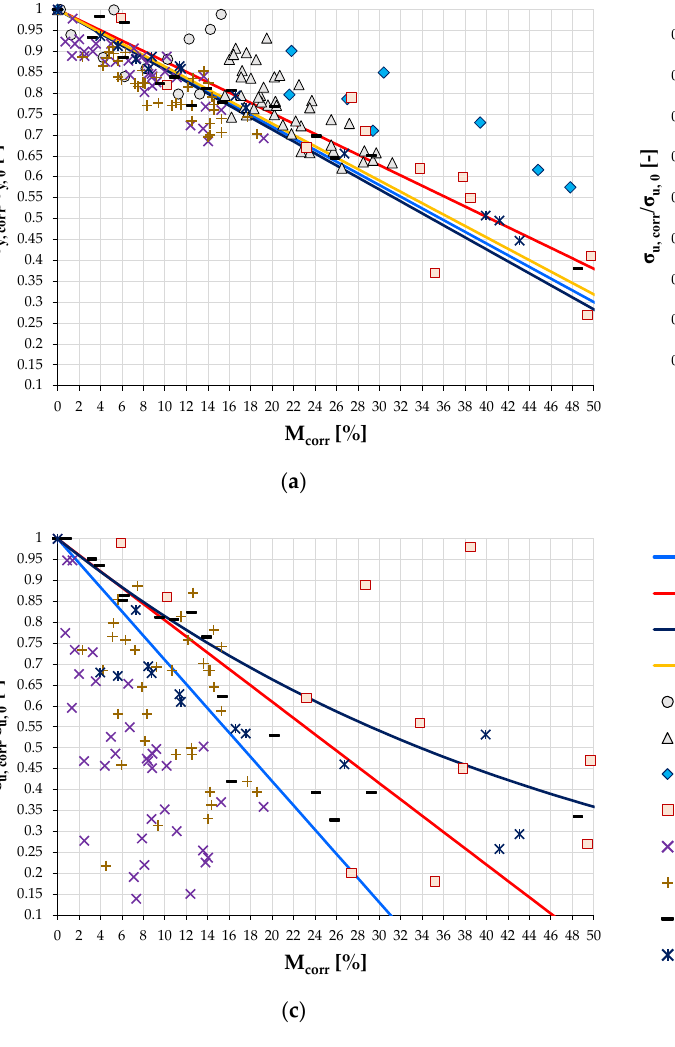
Figure 3. Comparison between the literature decay laws for uniform corrosion and the mechanical properties of naturally corroded rebars [13,26,29–31,33–35,40,41]: ( a ) yielding and ( b ) ultimate strength and ( c ) ultimate strain; ( d ) charts’